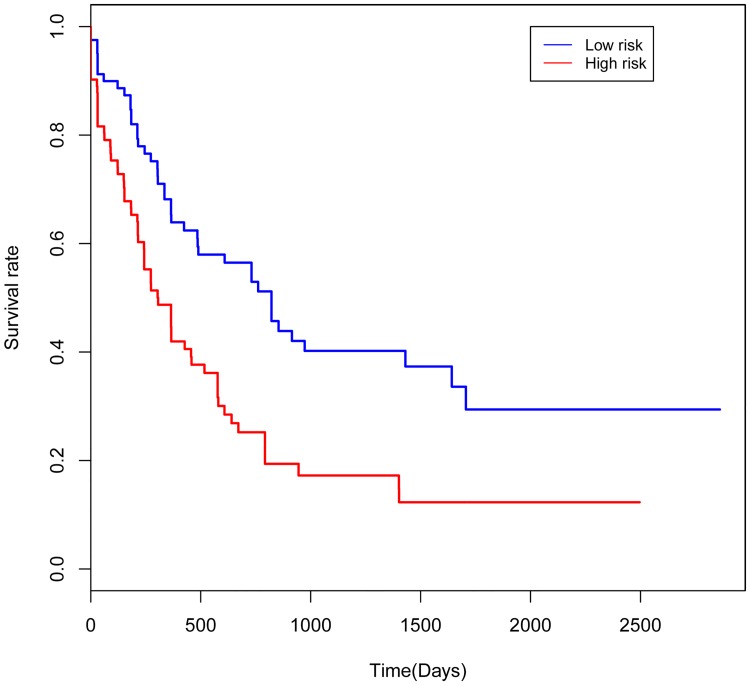
Kaplan-Meier curves showing AML patients dichotomized based on risk score in the validation group.High risk is defined as a risk score ≥ the median, and low risk is defined as a risk score < the median in the validation group.